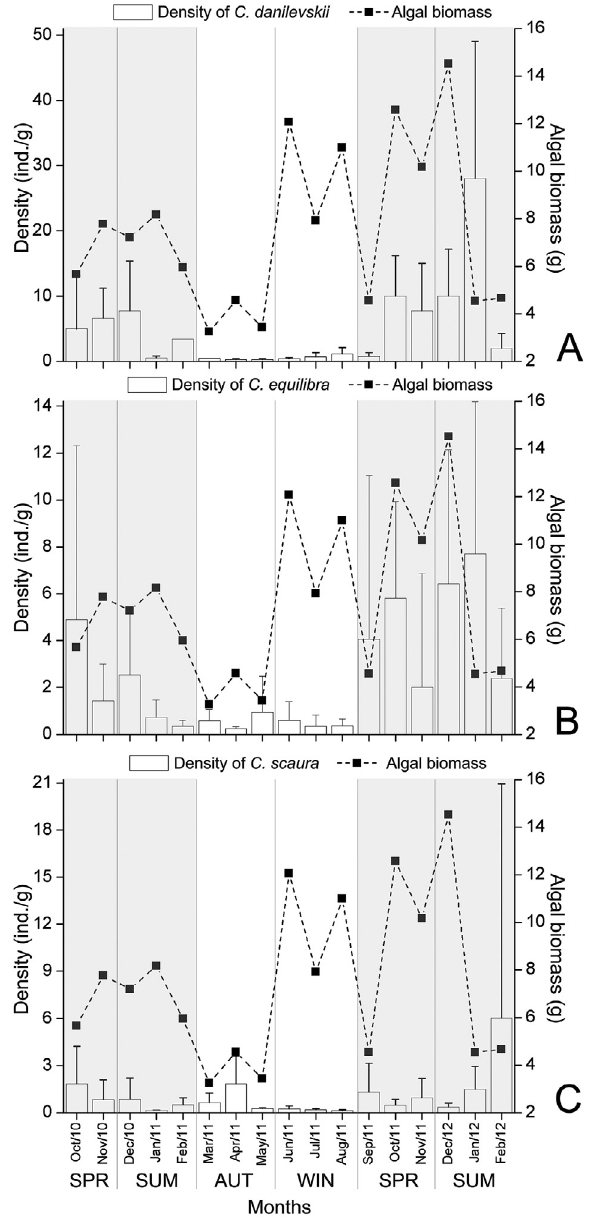
Fig. 5. – Monthly ecological parameters of the caprellids in association with Sargassum in the Ubatuba region, southeastern Brazil. Density (ind. g –1 ) of Caprella danilevskii (A), Caprella equilibra (B) and Caprella scaura (C) and the algal biomass (g). SUM, summer; AUT, autumn; WIN, winter; SPR,